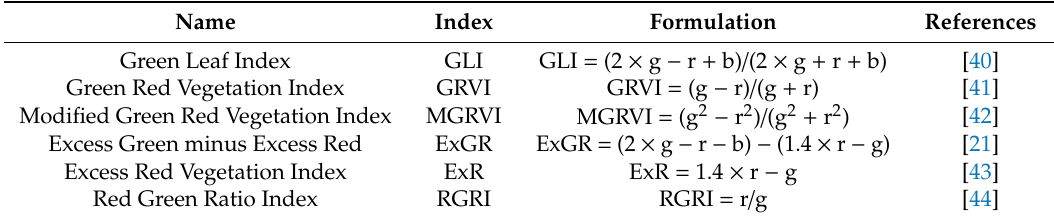
Table 4. List of vegetation indices (VIs) used in this